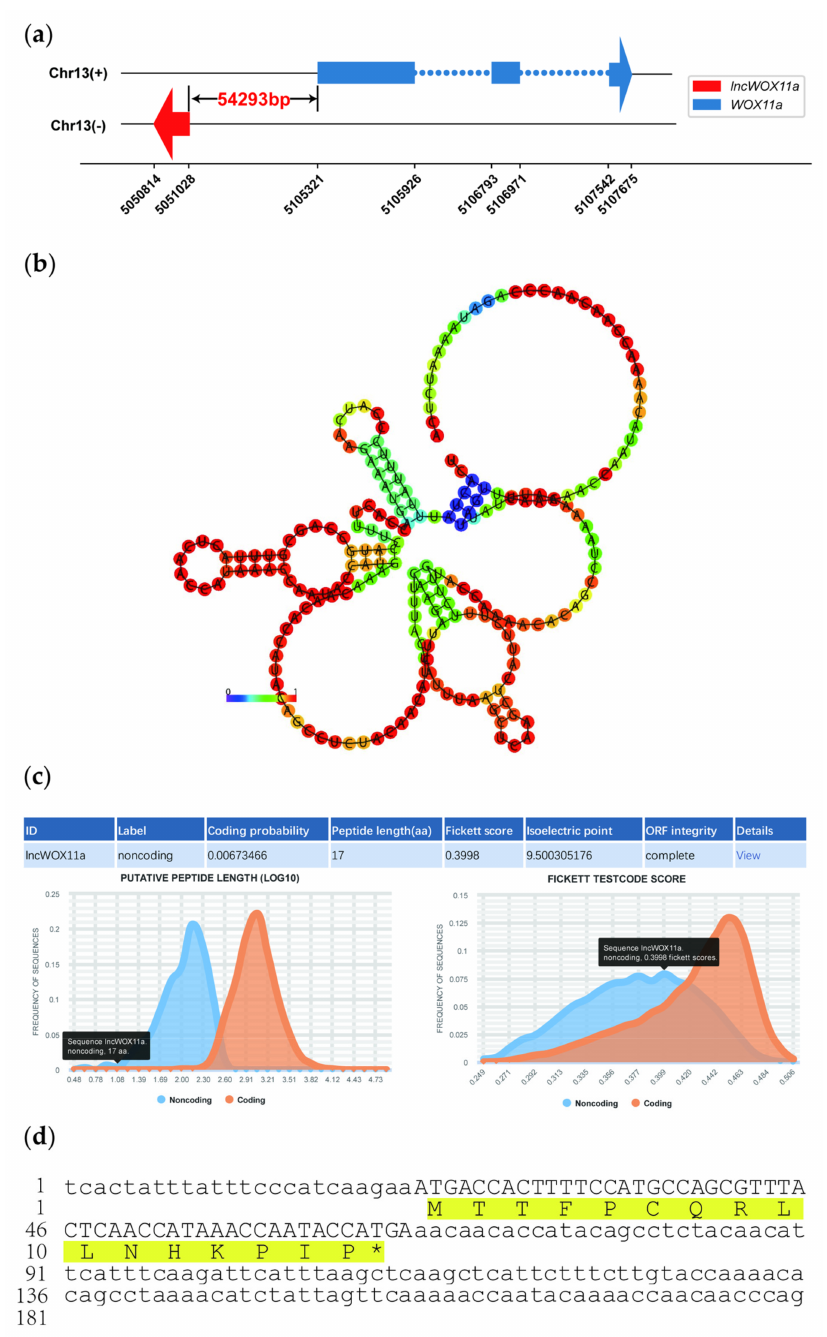
Figure 1. Sequence analysis of lncWOX11a . ( a ) Schematic representation of the lncWOX11a– PeWOX11a genomic region. ( b ) Prediction of the secondary structure of lncWOX11a . The different colors represent the level of minimum free energy. ( c ) Prediction of the coding ability of lncWOX11a by CPC2 software. ( d ) Nucleotide sequence of